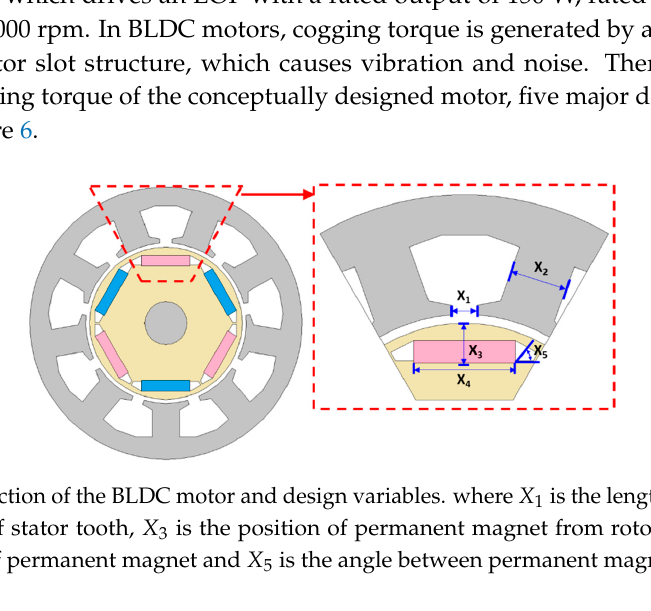
1 is the length of slot